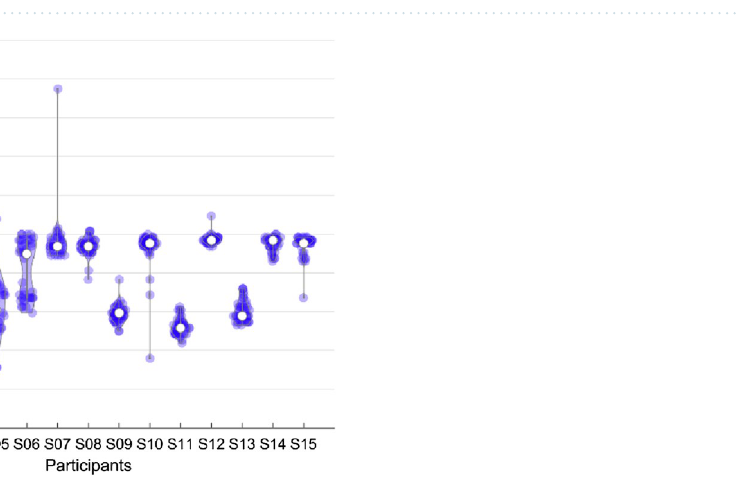
Figure 6. Online asynchronous classification accuracy and F1 score of the hierarchical approach per subject. ( a ) Classification accuracy of each participant is shown as a percentage. The magenta and gray bars represent the binary and multiclass performances, respectively. ( b ) F1 scores of each participant are displayed in green and red colors with regard to the two and four classes.